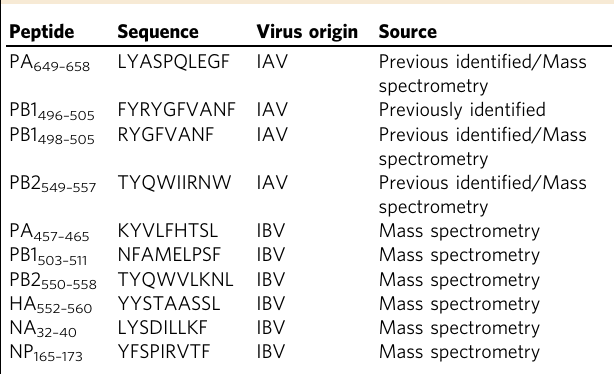
Table 3 Human immunodominant A24